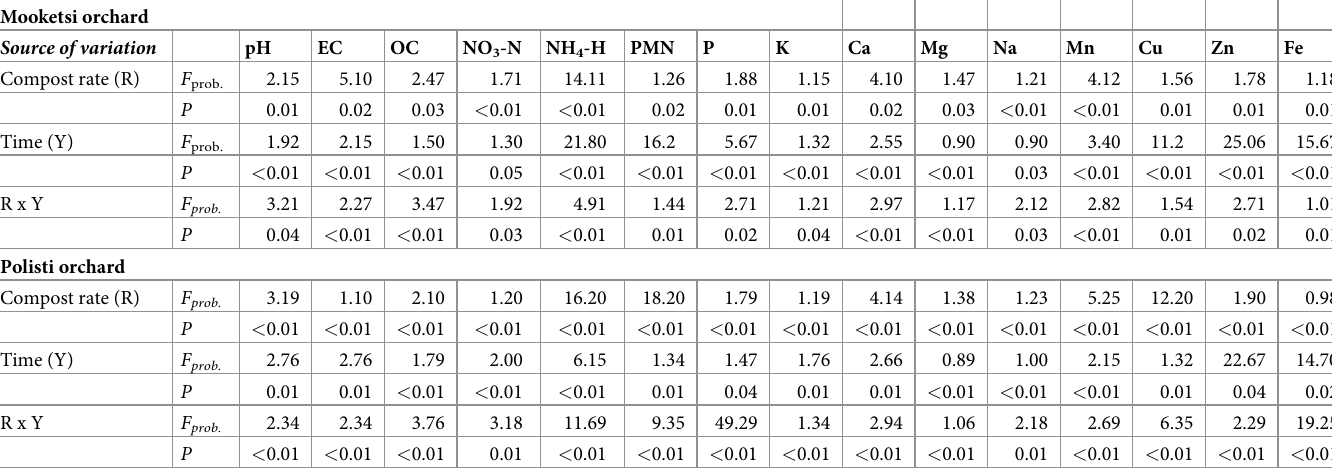
Table 4. ANOVA for pH, EC and organic carbon, and soil nutrient elements following a 3 year application of the eucalyptus–wood based compost at the Mooketsi and Pilisti orchards. Mooketsi orchard Source of variation Compost rate (R) F